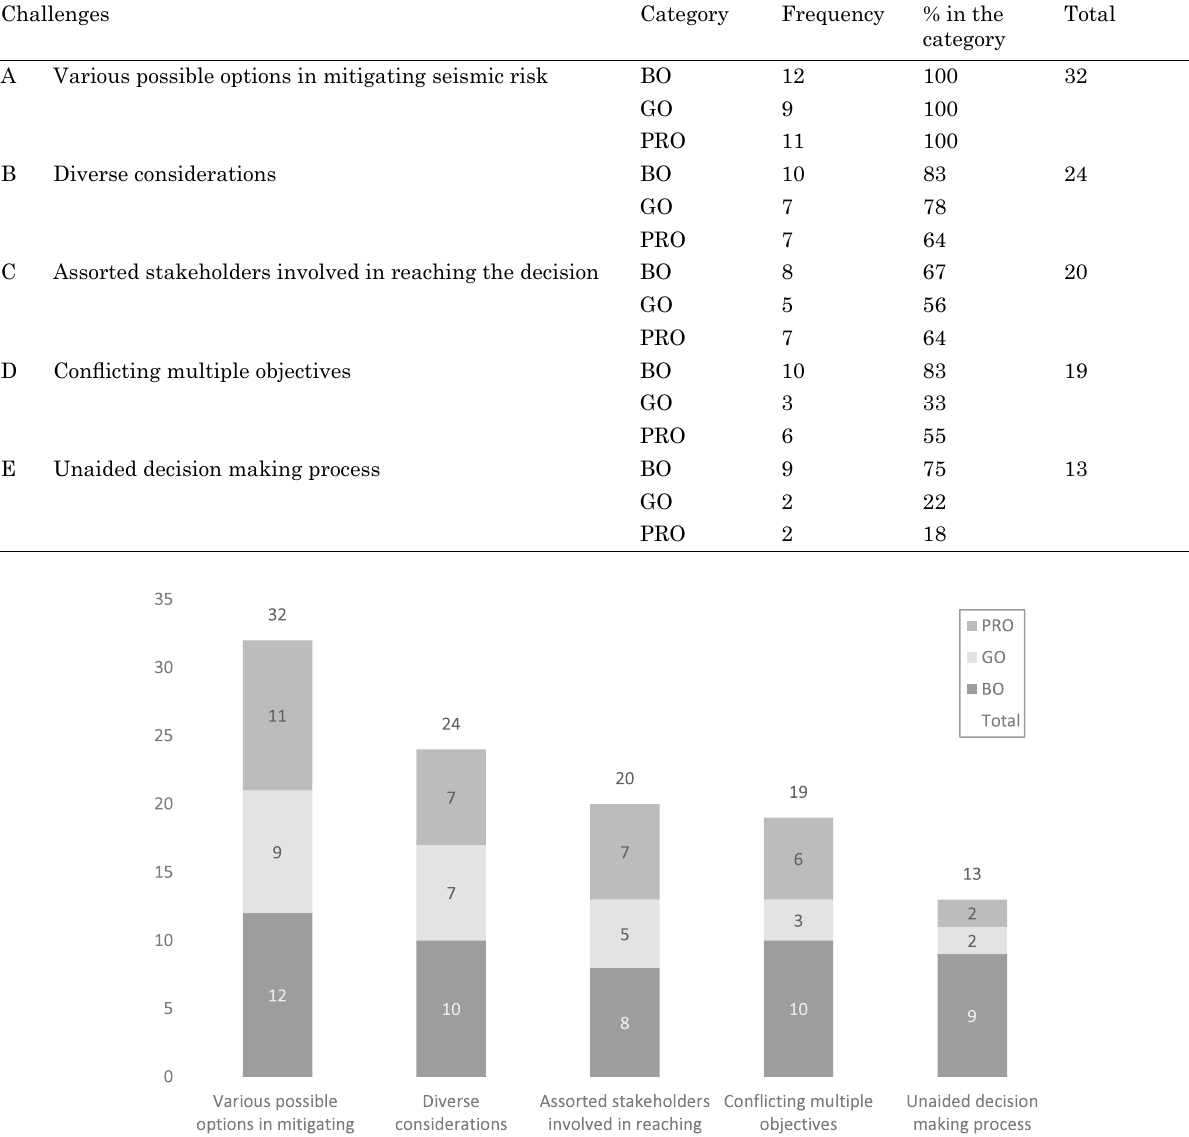
Table 3. decision-making challenges embedded in the decision environment Challenges